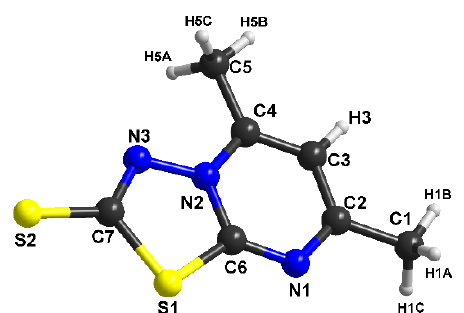
Materials 2020 , 13 , x FOR PEER REVIEW Figure 3. The molecular structure with atom numbering for ( 1 ). Figure 3. The molecular structure with atom numbering for ( 1 ).